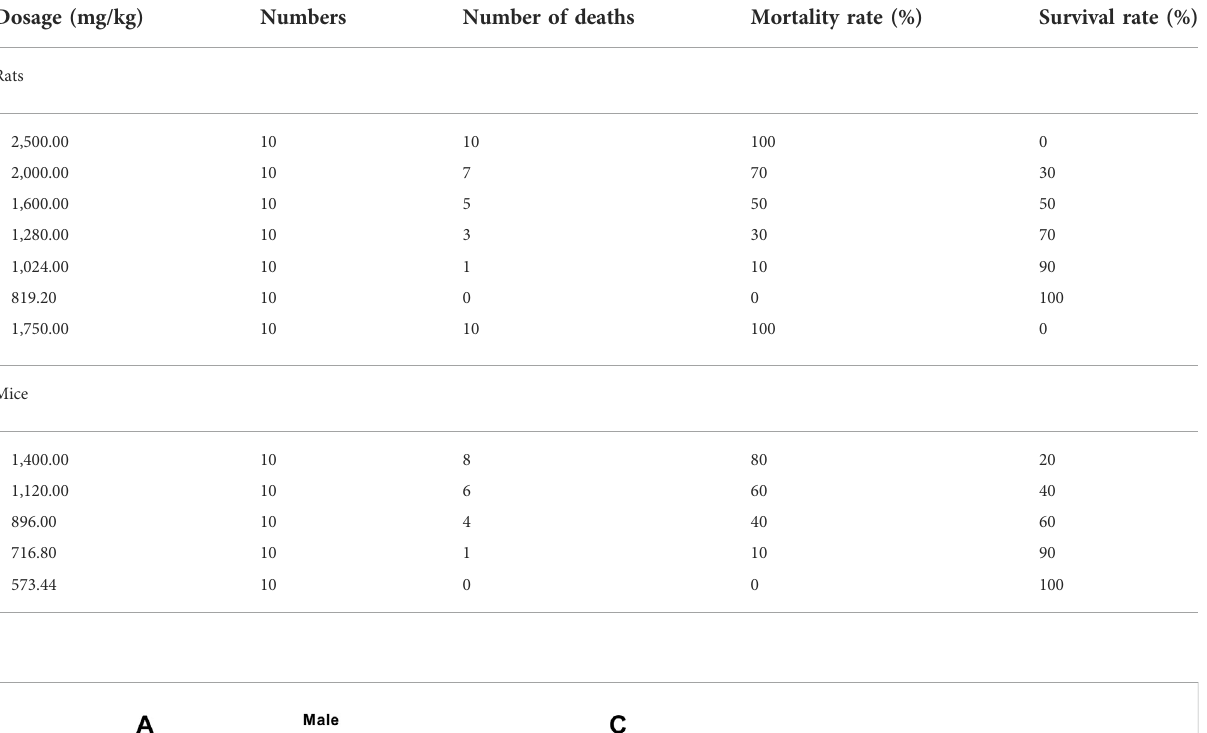
TABLE 2 Oral acute toxicity mortality in rats and mice at different doses of MCE.